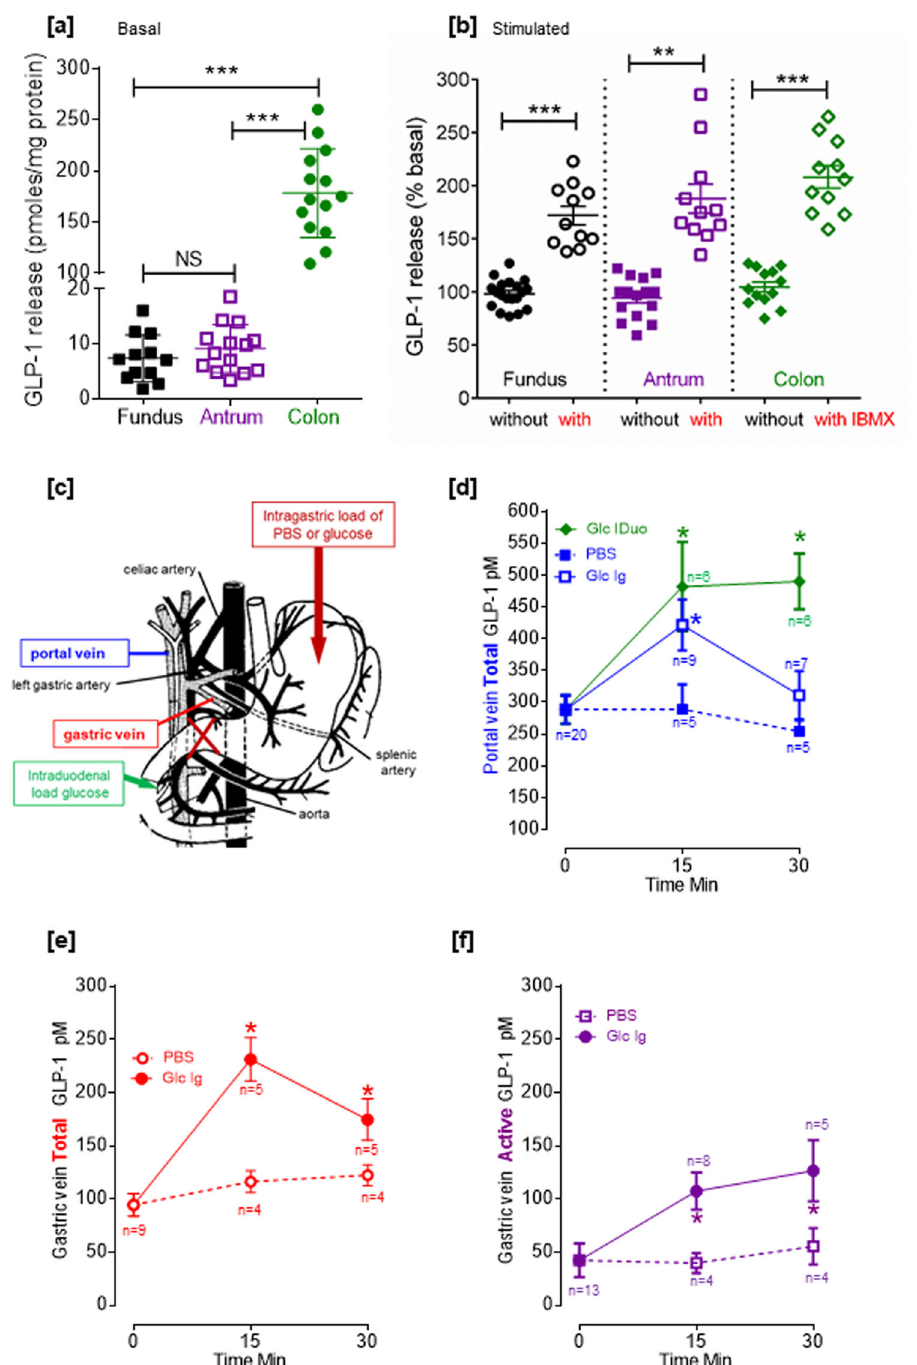
Fig. 2 The stomach produced active GLP-1 in response to a gastric glucose load. Spontaneous ( a ) and IBMX-stimulated ( b ) GLP-1 release from fundus, antrum, and colon fragments ex vivo . Stomach and colon from overnight fasted lean rat were collected and incubated for 1 h with PBS (without IBMX) and with 100 µ M IBMX. GLP-1 was assayed in the supernatant. Results are expressed as mean ± SEM in pmoles/mg protein for basal release in a with n = 12 for fundus and n = 14 for antrum and the colon and statistically analyzed with one-way ANOVA followed by Tukey ’ s multiple comparison test. *** P < 0.001, ** P < 0.01, and NS not signi fi cant. When stimulated with IBMX, results are expressed as mean ± SEM in percentage of basal release (without IBMX n = 19 for fundus, n = 15 for antrum, and n = 13 antrum and with IBMX n = 11 for fundus, antrum, and colon) and statistical analysis was performed using Mann – Whitney test to compared with and without IBMX ** P < 0.01, *** P < 0.001. c Scheme of the stomach showing the portal and gastric vein blood sampling and loading of PBS and glucose. d In vivo intragastric load of glucose increases total GLP-1 levels in the portal vein of anesthetized rat. Total GLP-1 levels after intragastric (Ig) or intraduodenal (IDuo) load of glucose (2 g/kg BW) or PBS measured in the portal vein (blue: Ig Glc and PBS; green: IDuo Glc). Data are the mean ± SEM of n values indicated at each time point on the graph. Data were analyzed by a two-way ANOVA. * P < 0.05 vs. PBS. Total ( e ) and active ( f ) GLP-1 levels increase after intragastric load of glucose in the gastric vein of anesthetized rat. Total and active GLP-1 levels after an intragastric (Ig) load of glucose (2 g/kg BW) or PBS measured in the gastric vein. Data are the mean ± SEM, n values indicated at each time point on the graph, and data were analyzed by a two-way ANOVA. * P < 0.05 vs. PBS. Source data are provided as a Source data fi le. NATURE COMMUNICATIONS| (2021) 12:110 |https://doi.org/10.1038/s41467-020-20301-1|www.nature.com/naturecommunications